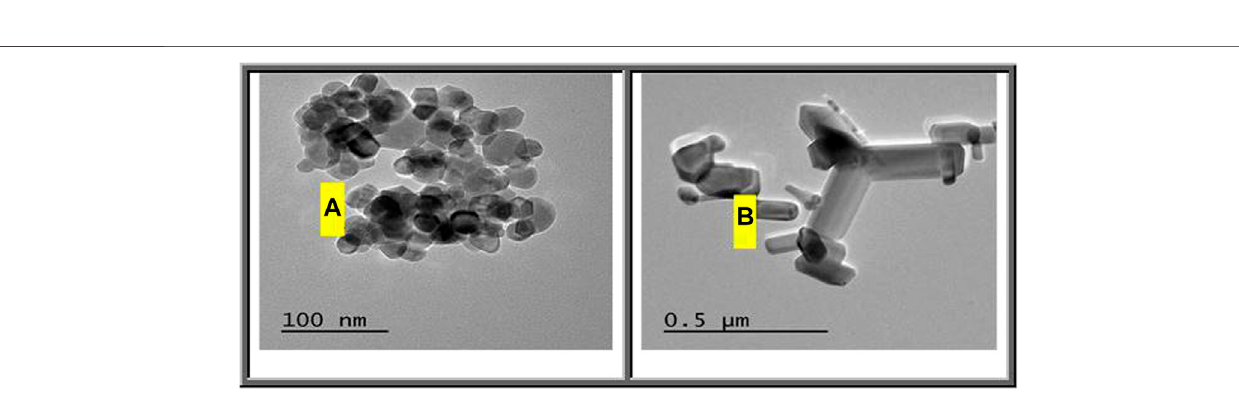
FIGURE 1 | SEM image and particle size distribution of the synthesized (A) and commercial (B) ZnO.